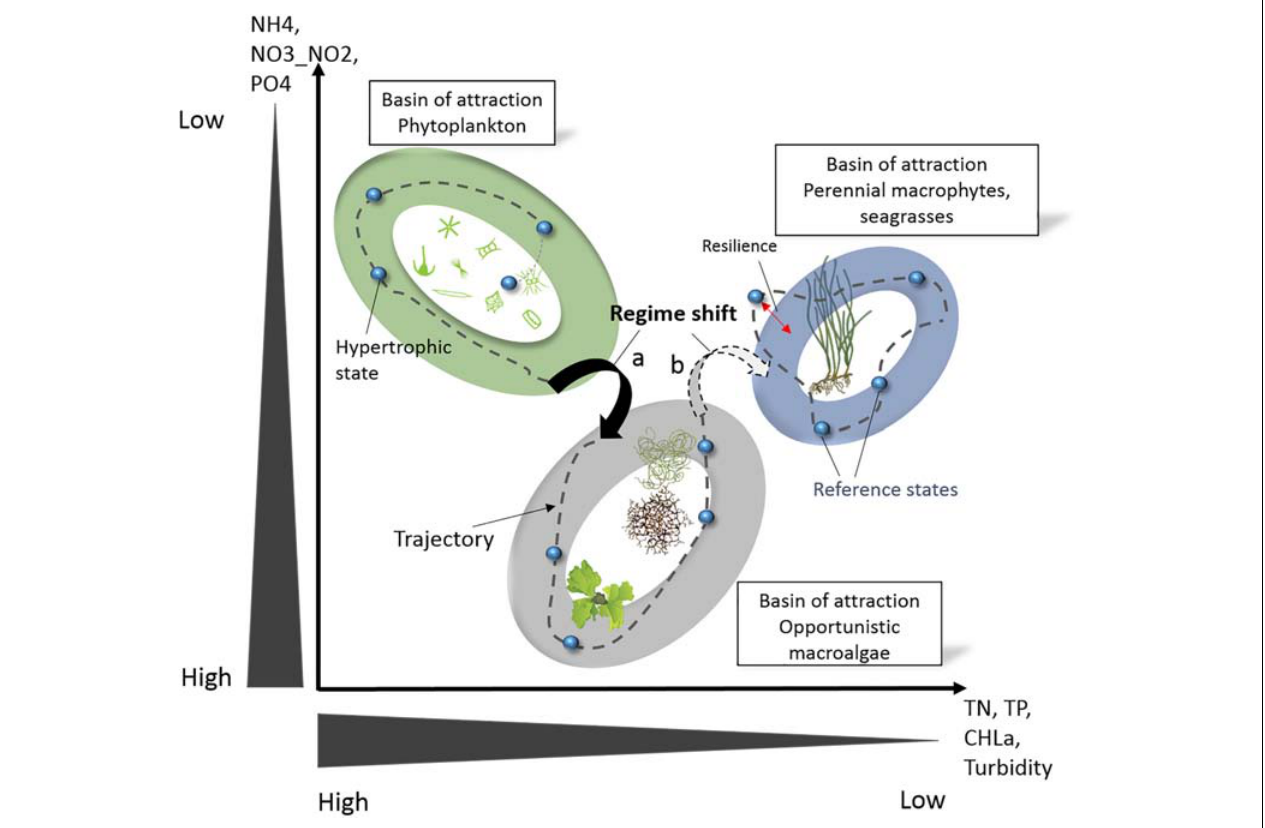
FIGURE 6 | Illustration of ecosystem states and regime shifts along oligotrophication trajectories in Mediterranean coastal lagoons. The ellipses represent the three basins of attraction that were identified, i.e., three ecosystem states dominated by (i) phytoplankton with bare non-vegetated sediments, (ii) opportunistic macroalgae, and (iii) seagrass and perennial macroalgae. The small blue spheres represent the different ecosystem states and the stippled lines their trajectory according their chronology. Small pictograms courtesy of the Integration and Application Network, University of Maryland Center for Environmental Science (ian.umces.edu/symbols/). Creative Commons license, reproduced from Le Fur et al.